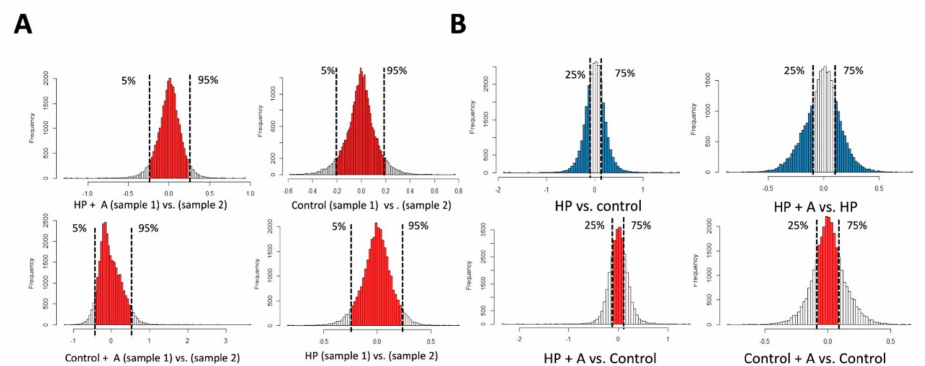
Figure 3. Distribution plots of all examined probes upon intra-group and inter-group comparisons. ( A ) The illustrations of intra-group comparisons between biological duplicates of HP + A (left upper), control (right upper), control + A (left lower), and HP (right lower). ( B ) Inter-group comparisons between HP and control (left upper), between HP + A and HP (right upper), between HP + A and control (left lower), and between control + A and control (right lower). A, astaxanthin; HP, high